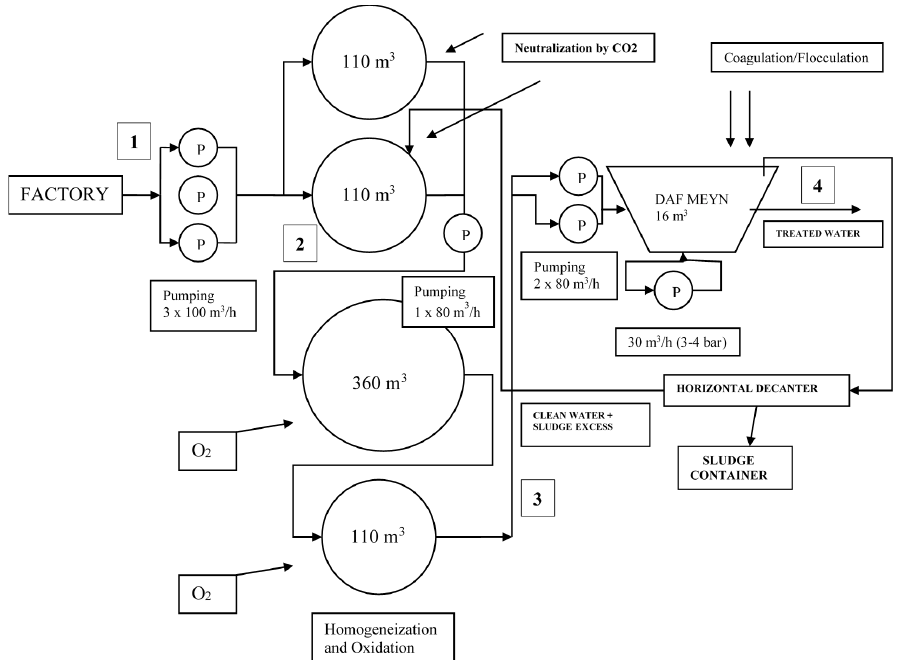
Figure 2. Dairy wastewater treatment plant layout. Sampling points considered for this work were: 1.—entrance of the plant (inlet); 2.—after neutralization under CO 2 ; 3.—after O 2 injection; and 4.—